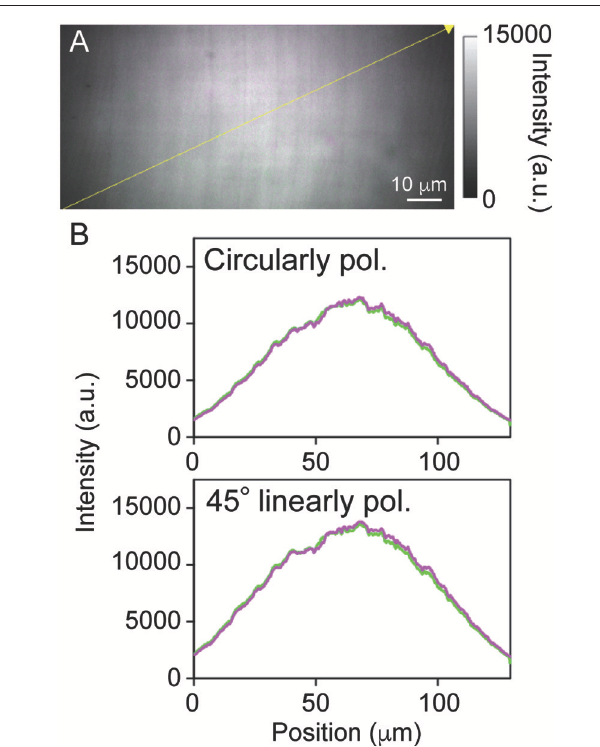
FIGURE 2 | (A) A two-photon excitation fluorescent image of a sulforhodamine B solution. (B) Fluorescent intensity profiles taken along the yellow line in the fluorescent image between the s- and p-polarized components, here colored in green and magenta, respectively. The upper and lower panels show circularly polarized and 45 ◦ linearly polarized excitation light irradiation, respectively. The exposure time was 90ms, the pixel size was 230nm × 230nm, and the FOV size was 118 µ m × 55 µ m (512 pixels × 240 pixels).